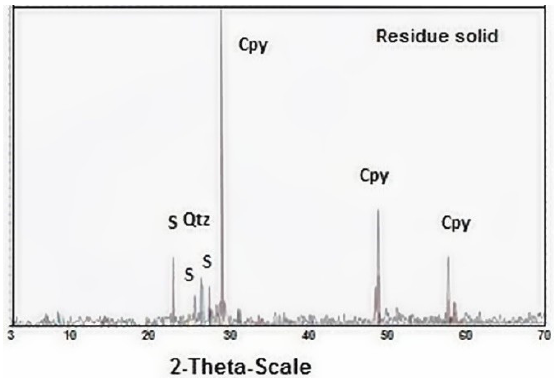
Figure 8. X-ray diffraction patterns of the solid residue from leaching at pH 1 and 2.5 g L −1 Cu 2+ and 5 − 1 Cl − g L −1 Cl − . 5 g L